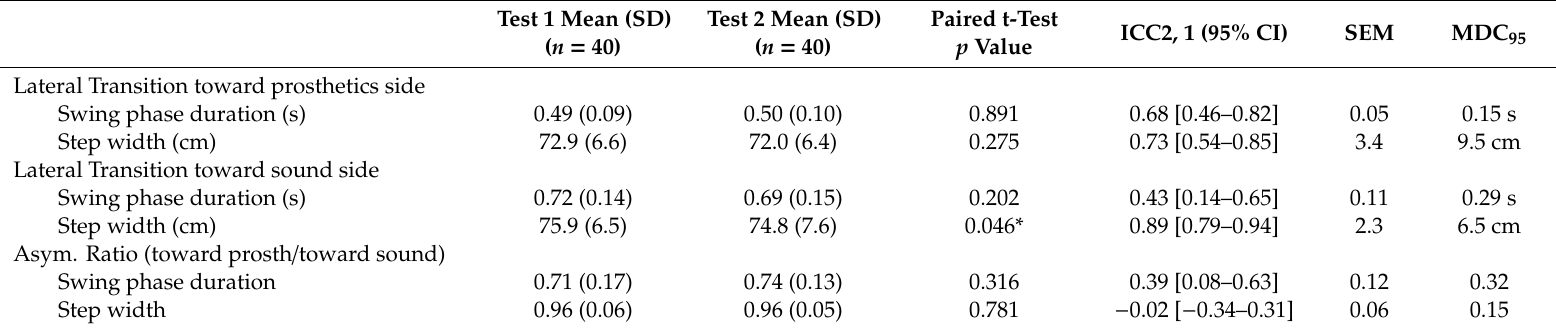
Table 3. Test-retest reliability and minimal detectable change values of iFSST variables (decomposition based on prosthetic side and sound